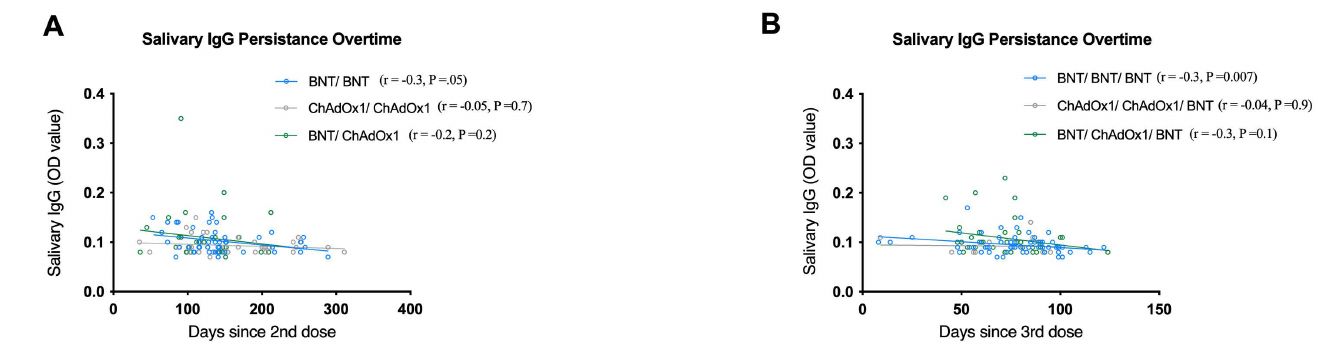
Figure 2. Correlation between salivary IgG levels and time since the 2nd dose ( A ) and 3rd dose ( B ) following different vaccination regimens. Spearman correlation analysis was used to determine rho and p